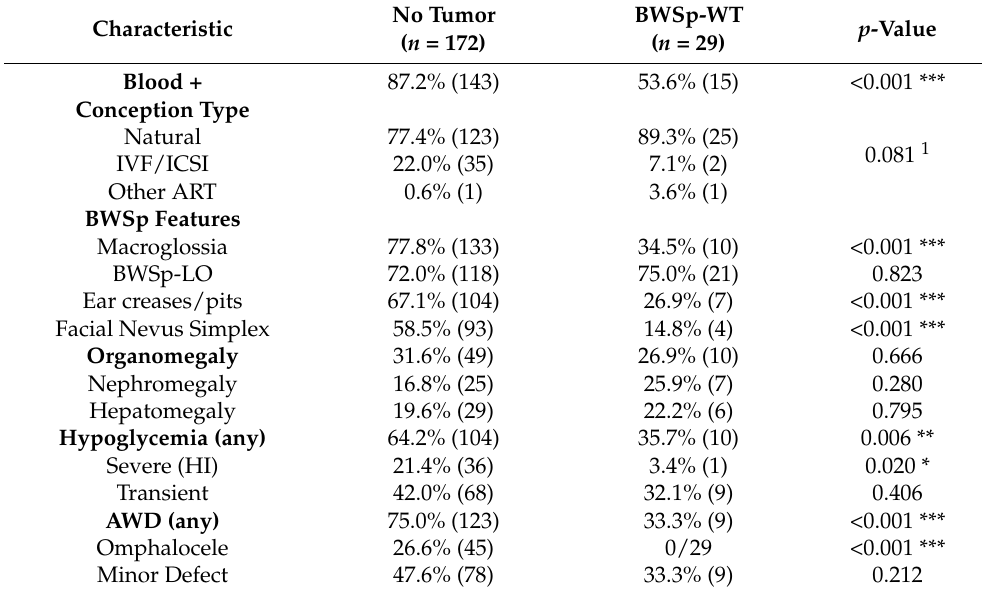
Table 8. Wilms (WT)-associated phenotypes within BWSp population.